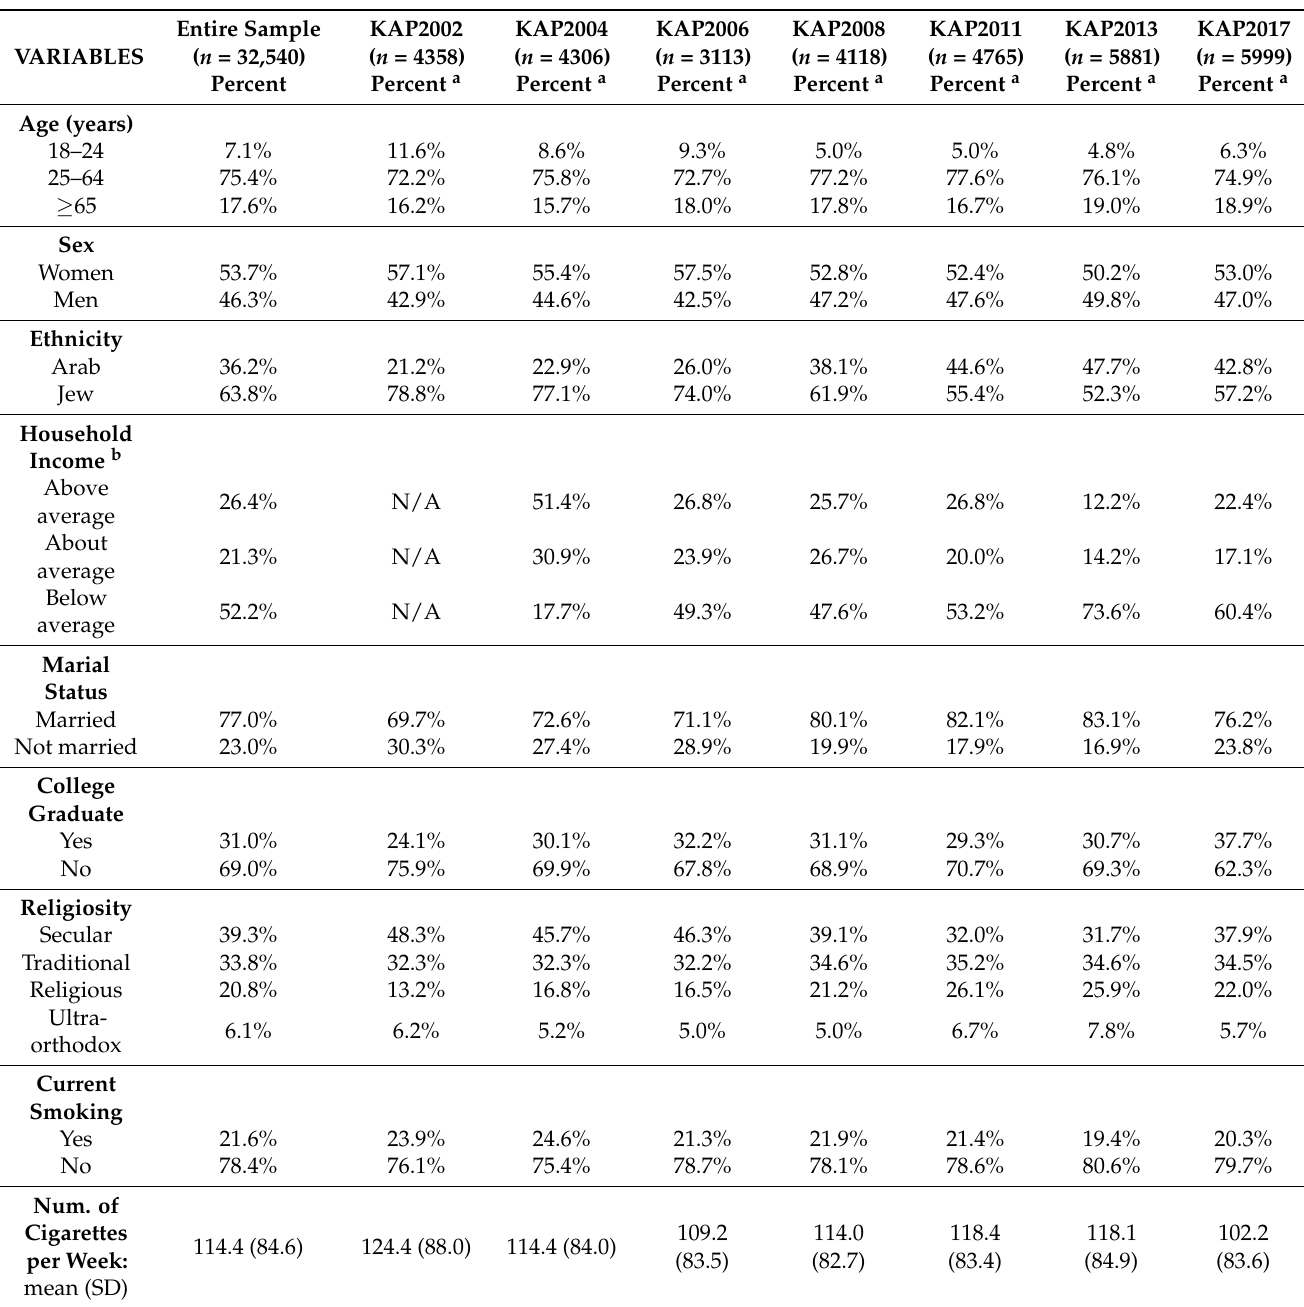
Table 1. Characteristics of study sample: entire sample and by survey wave (KAP